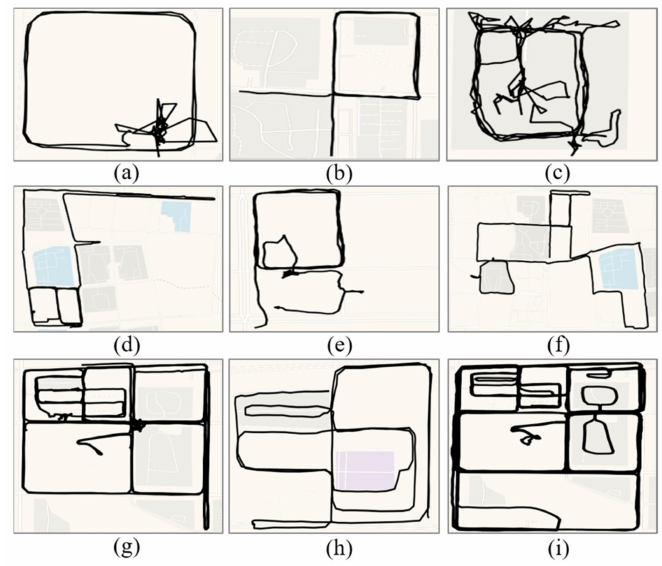
Figure 11. Examples of the trajectories of loitering that were extracted from the TucityLife dataset. ( a ) Loitering and stopping; ( b ) loitering; ( c – f ) loitering and leaving briefly; ( g – i ) multiple areas are examined simultaneously.